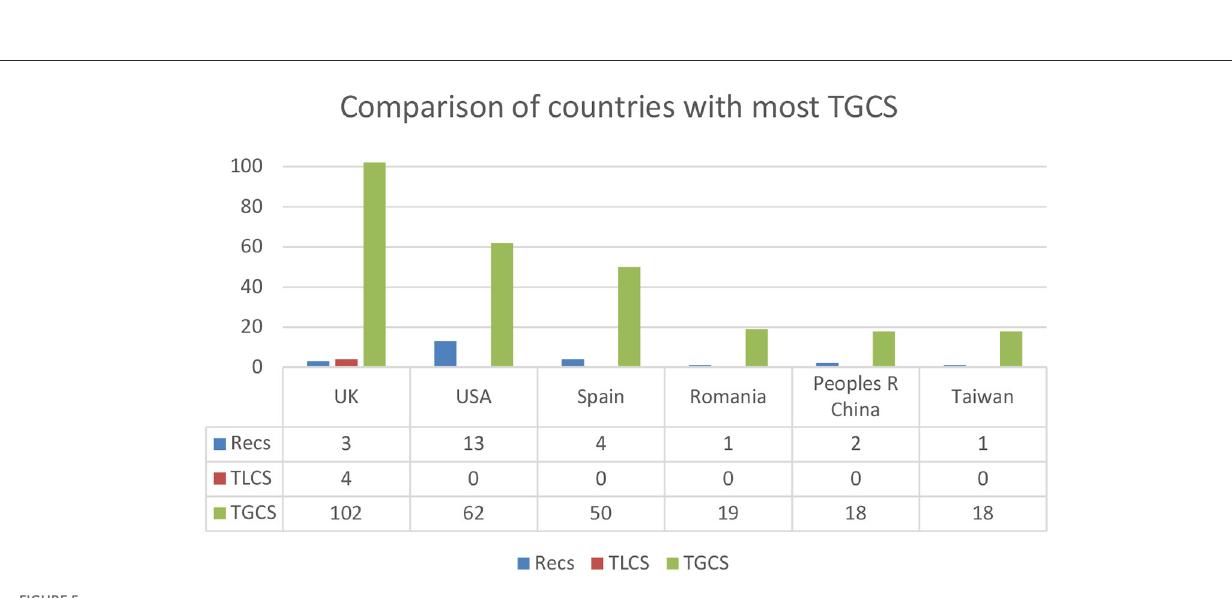
FIGURE5 Comparison of countries with the most global citations ( ≥ 18 GCTS). Recs, number of articles; TLCS, Local Citation Score; TGCS, Global Citation Score.